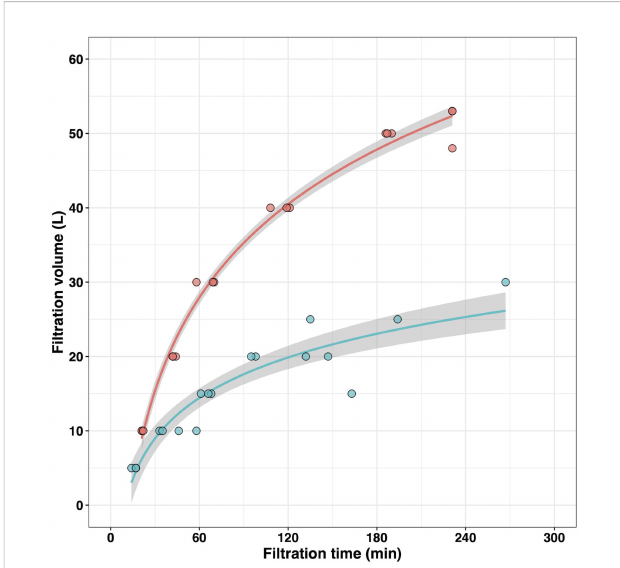
FIGURE 1 Time pro fi le of the fi ltration volume collected at Akazawa and Yaizu. Circles represent experimental values. Lines and shadowed bands indicate the approximate curves and 95% con fi dence interval, respectively. Red and cyan represent information from Akazawa and Yaizu,